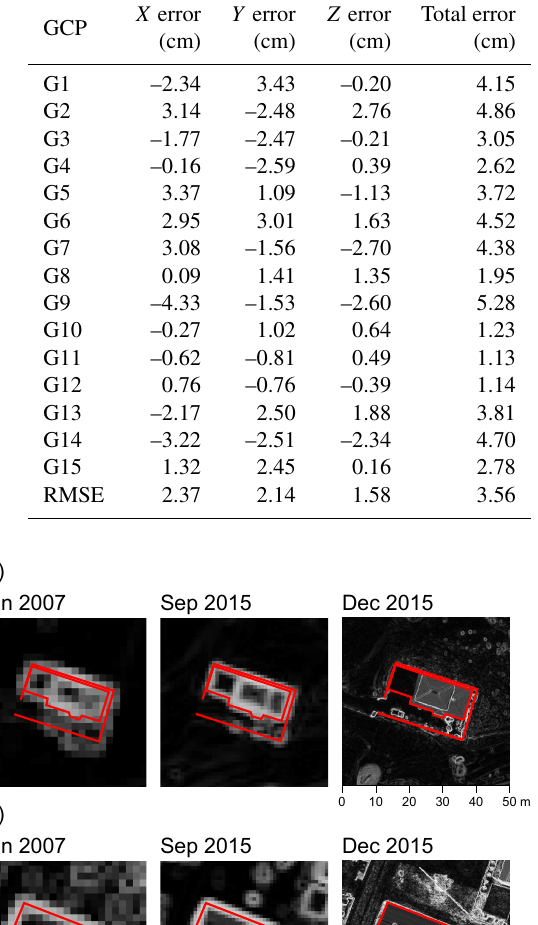
Table 1. Error of each ground control point (GCP) and RMSEs for all 15 GCPs in the SfM processing.